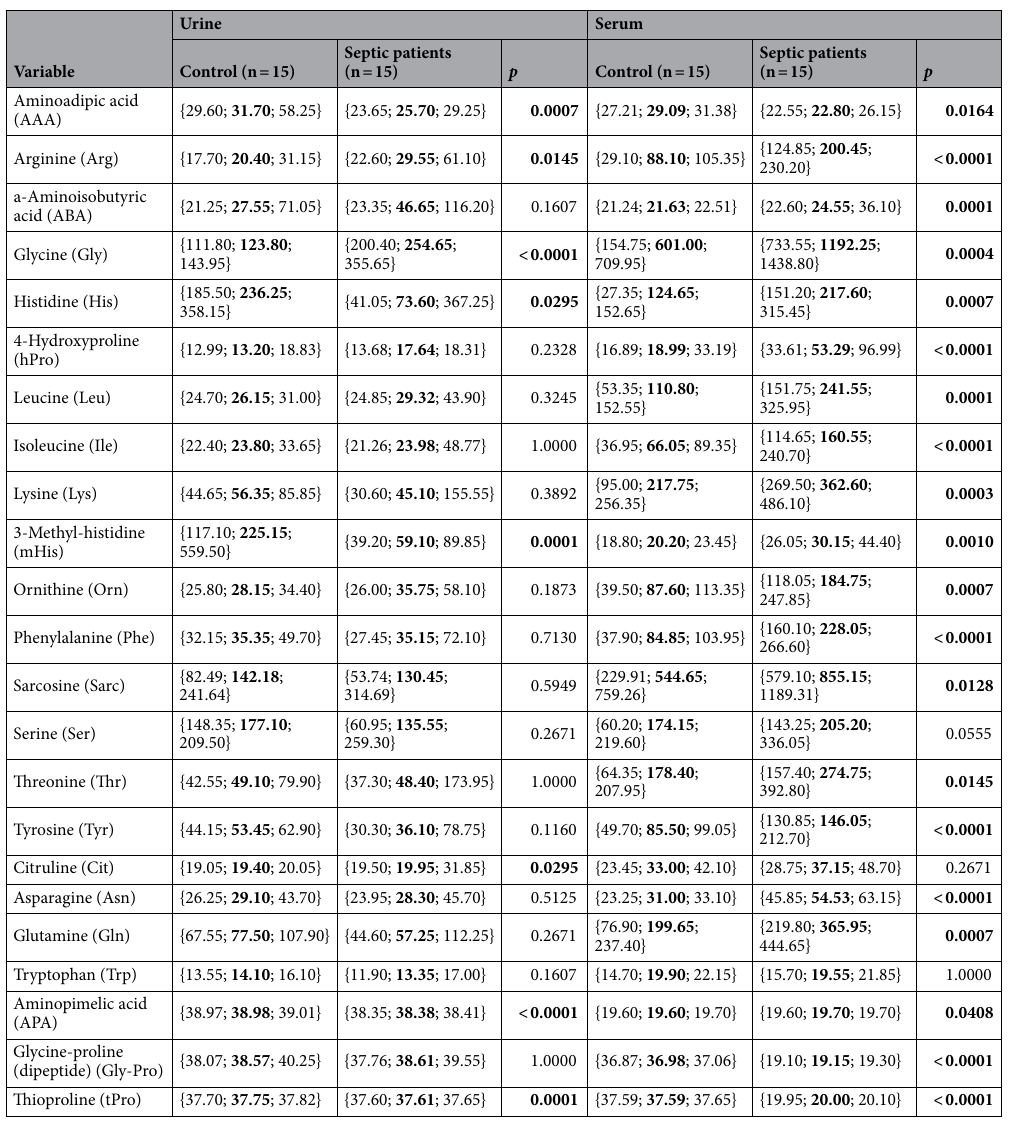
Table 1. A comparison of the amino acids in the urine and serum in the control group and septic patients. Data is presented as {1st quartile; median value; 3rd quartile}; cases in which p < 0.05 (U Mann–Whitney test) are marked in bold. The median value is expressed as